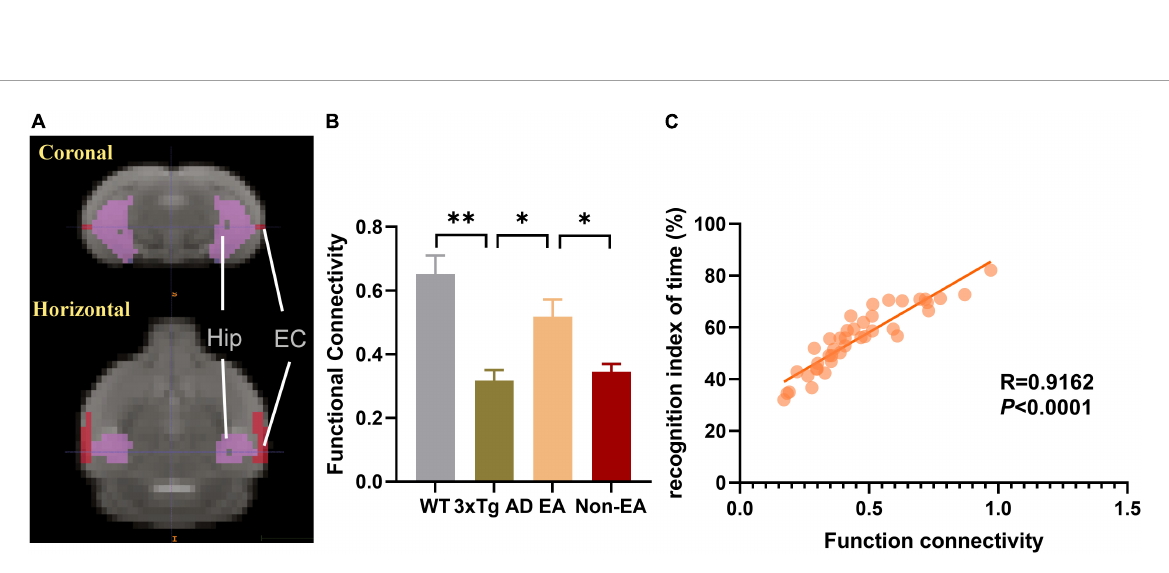
FIGURE6 Effects of the EA-treatment on function connectivity between the hippocampus and entorhinal cortex. (A) Representative location image of hippocampus and entorhinal cortex. (B) Quantification of the function connectivity strength between the hippocampus and entorhinal cortex, (C) and the correlational analysis between the recognition index of time and function connectivity ( n = 10 in each group). All data represent the mean ± SEM. ∗ P < 0.05; ∗∗ P <